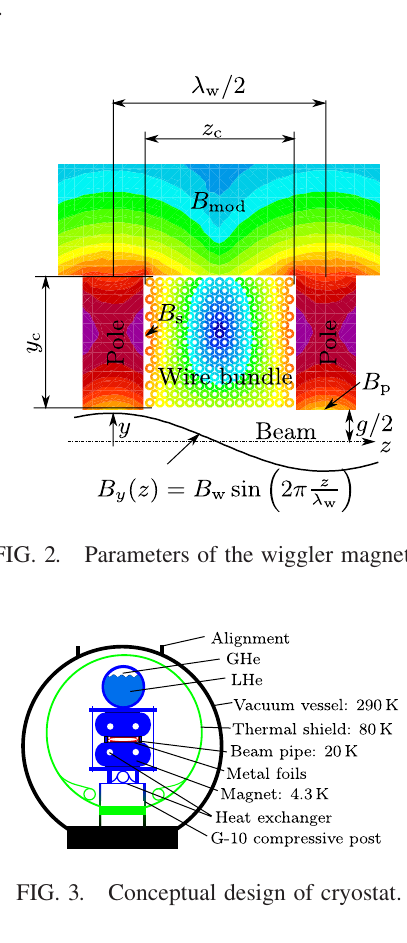
FIG. 1. Comparison of vertical versus horizontal emittances of different storage rings below 5 GeV with the CLIC damping rings [45].